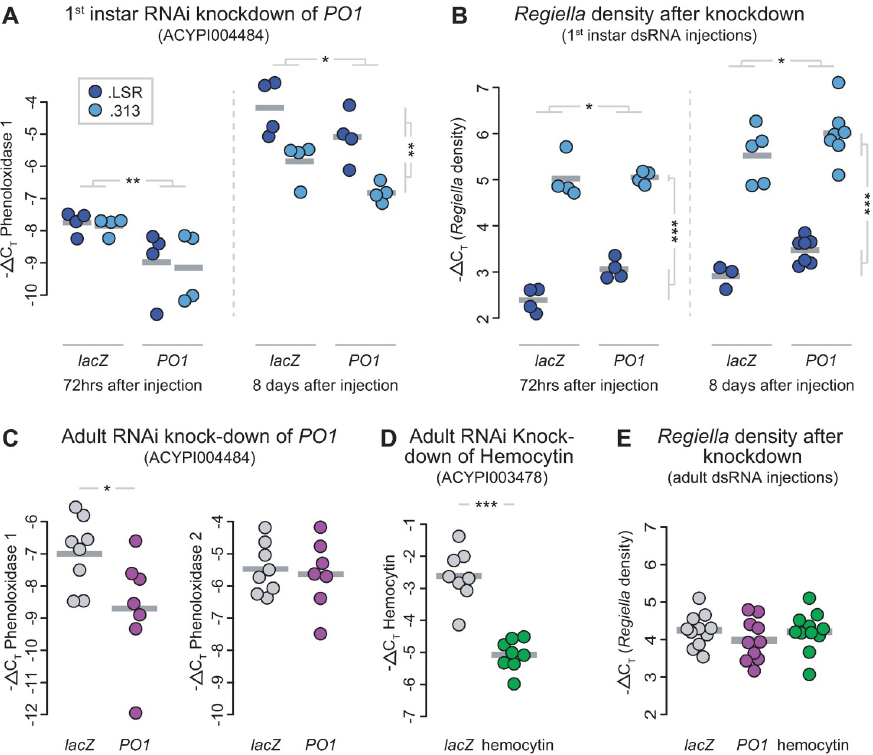
Fig 2. RNAi knockdowns and Regiella density. A: Validation of the RNAi knockdown for PO1 in 1 st instar aphids. The y-axis shows - Δ C T values of expression, which can be interpreted on a log 2 scale. Collection time-points (72 hours or 8 days) and treatment are shown along the bottom of the figure; the two Regiella strains are represented by different colors as shown in the key. Grey bars show the mean of each treatment group, with biological replicates shown as points. Statistical significance (2-way ANOVA & Tukey’s HSD post-hoc analysis) among treatment groups ( lacZ vs. PO1 ) is shown along the top of each plot, with an � , �� , or ��� indicating altered gene expression at p < 0.05, p < 0.01, or p < 0.001, respectively. Significance among Regiella genotypes (.LSR vs .313) is shown along the right side of each plot . B: Regiella density after knockdown of aphids injected as 1 st instars. The y-axis shows - Δ C T values of symbiont density, which can be interpreted on a log 2 scale. Time-points, treatment, Regiella strain, and statistical significances (2-way ANOVA & Tukey’s HSD post-hoc analysis) are indicated as in A. C: Validation of the RNAi knockdown for PO1 in adult aphids. Y-axes are as above, treatment is shown along the bottom of the figures, with lacZ and PO1 dsRNA-injected aphids represented by grey and purple dots, respectively. Grey gars shown mean expression for a treatment. The left panel shows expression of PO1 , and the right panel shows expression of the other copy of phenoloxidase in the aphid genotype ( PO2 ). Statistical significances (t-tests) are shown as above. D: Knock-down validation of hemocytin. E: Regiella density after knockdown of aphids injected as adults. Grey, purple, and green points represent different treatments ( lacZ , PO1 , and hemocytin dsRNA injections, respectively). The y-axis shows Regiella density measured by - Δ C T values as